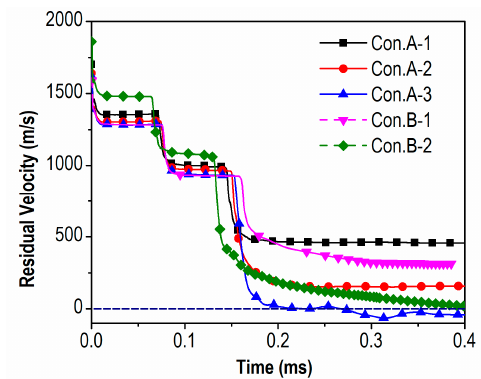
Figure 9. The projectile residual velocity versus time.